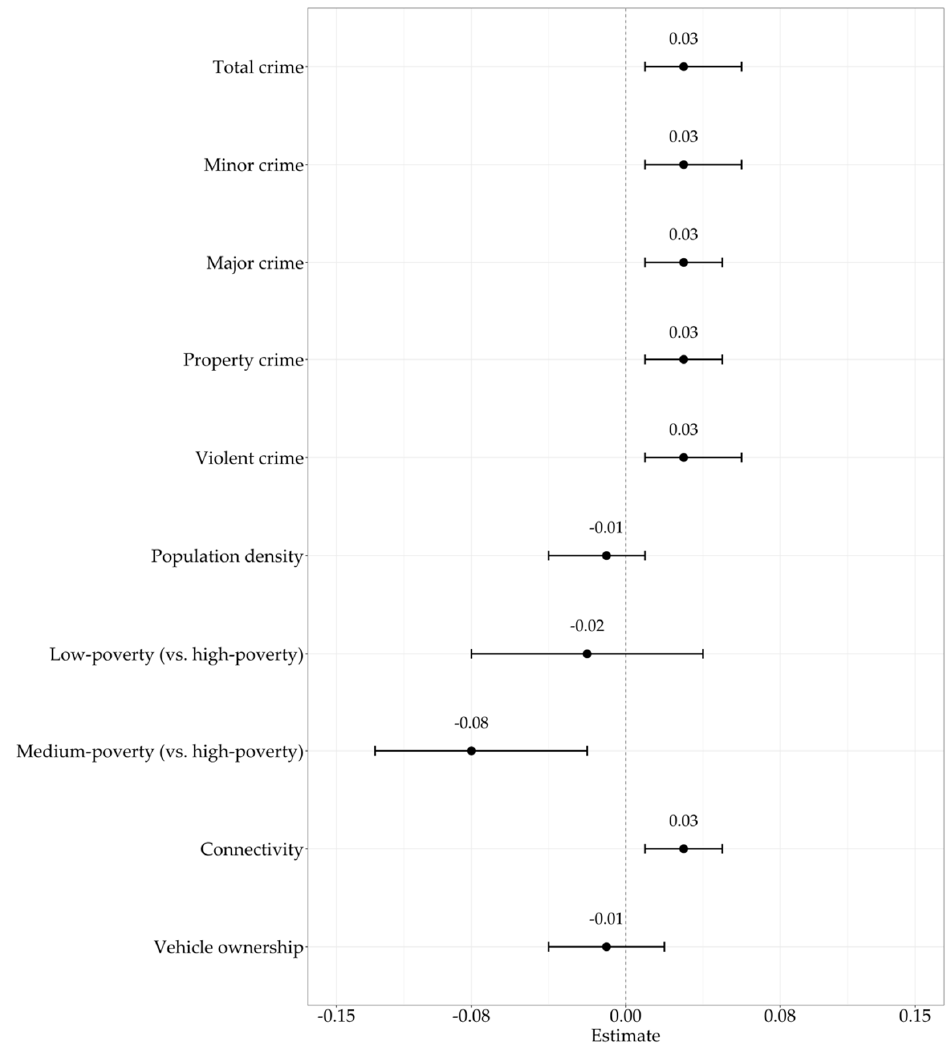
Figure 1. Unadjusted models for police-reported crime types and ACS.